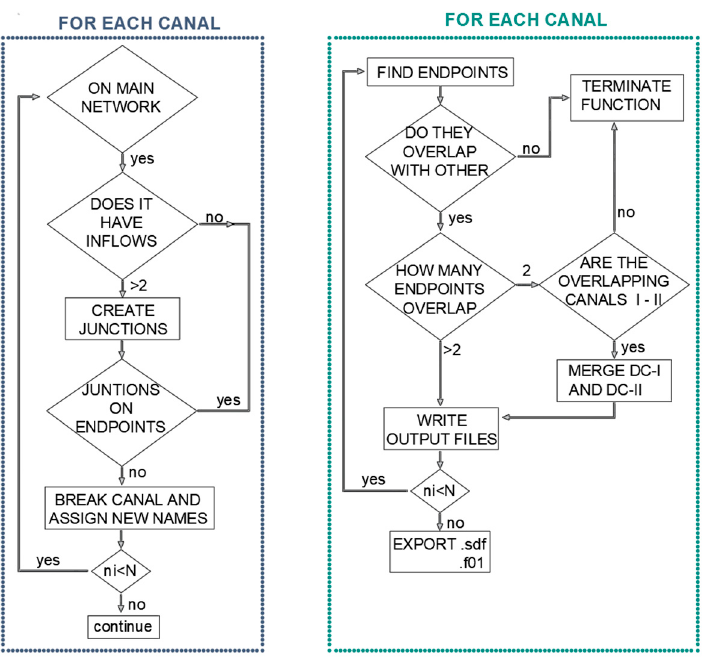
Figure 6. Flow chart of the function block depicting the creation of hydraulic junctions (left) and creation of HEC-RAS input files (right).